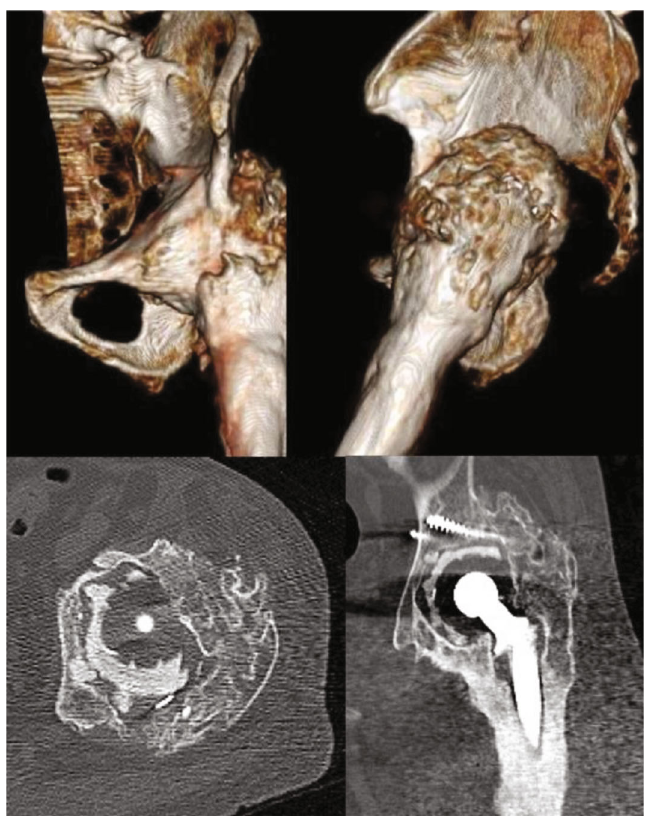
Figure 2: Three-dimensional computed tomography images showing severe heterotopic ossi fi cation around the hip joint and loosening of the acetabular cup in a 78-year-old